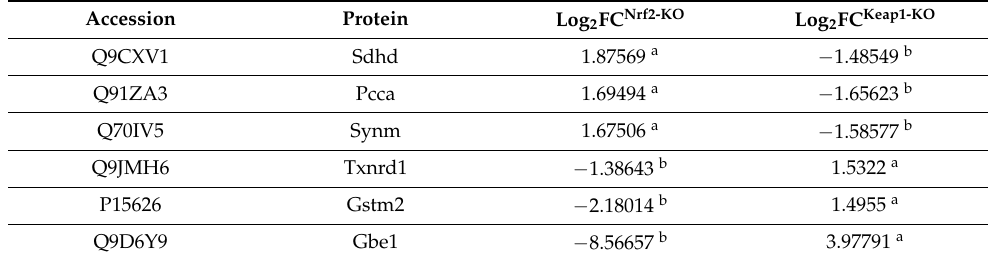
Table 1. Common significantly differentially expressed proteins in Nrf2- and Keap1-deficient mice. Accession Protein Log 2 FC Nrf2-KO Log 2 FC Keap1-KO Q9CXV1 Sdhd